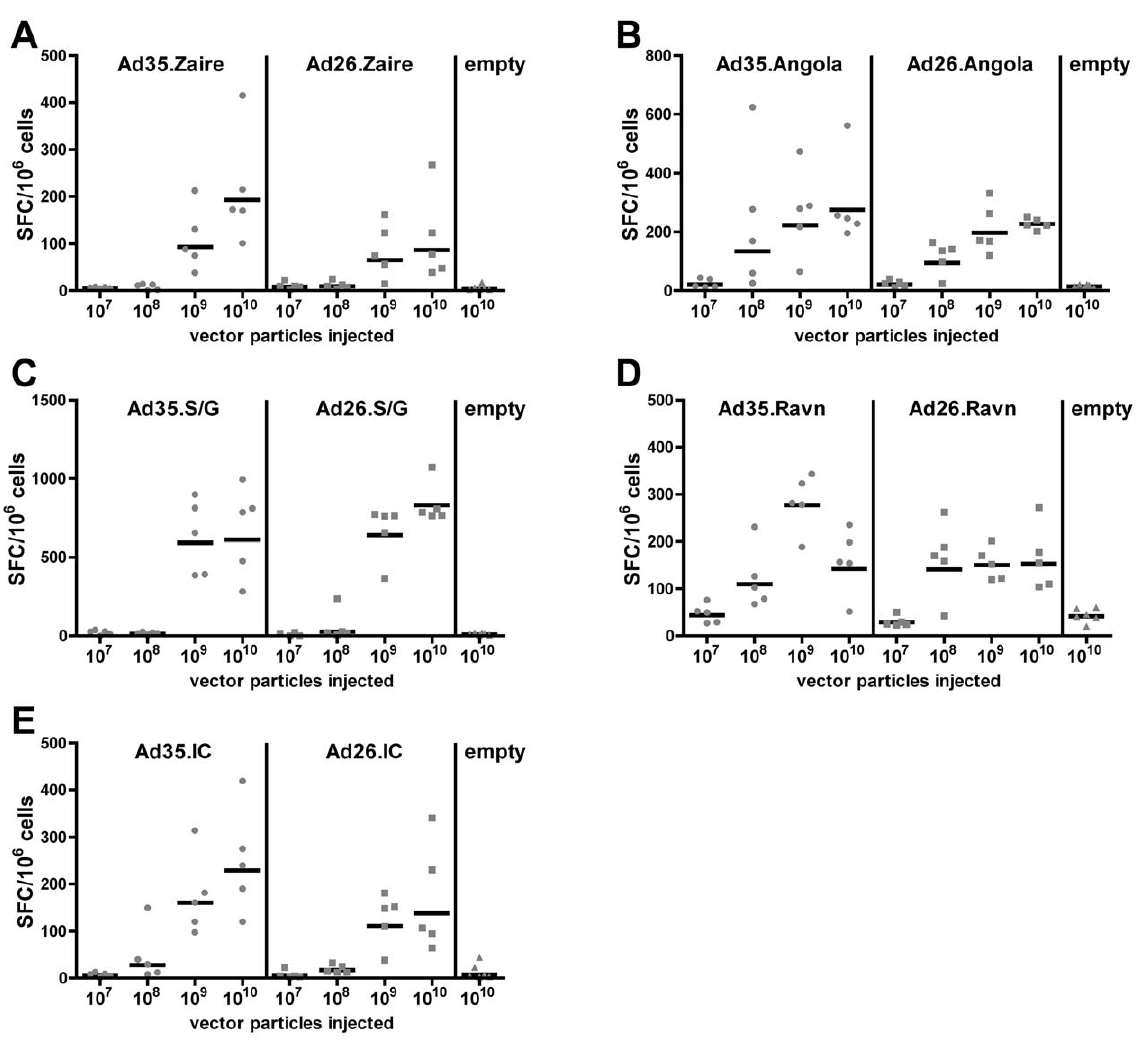
Figure 3. Dose dependent cellular immune response of filovirus rAd26 and rAd35 vectors. The cellular immune response was detected by ELISPOT of isolated splenocytes from mice either infected with 10 7 to 10 10 vp of rAd26 or rAd35 coding for the glycoprotein Ebola Zaire (A), Ebola Sudan Gulu (C), Ebola Ivory Coast (E), Marburg Angola (C), or Marburg Ravn (D). For each individual experiment three mice each were immunized with rAd26 or rAd35 without a transgene in the E1 region. Displayed is the total number of strain specific filovirus glycoprotein responsive splenocytes in spot forming colonies per million cells (SFC/10 6 cells). The bar represents the geometric mean of five mice and the grey balls an individual mouse.